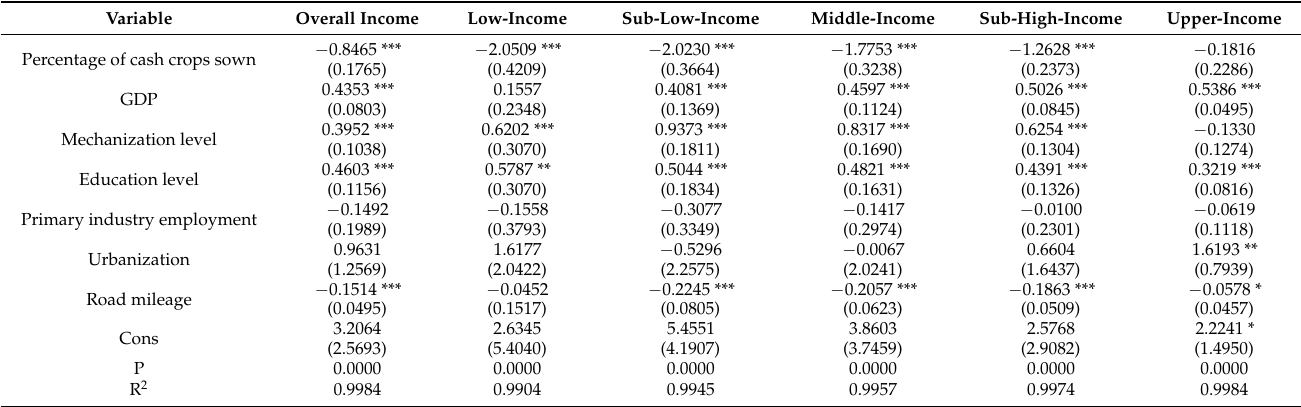
Table 4. Robustness test 1: Estimation of instrumental variables.